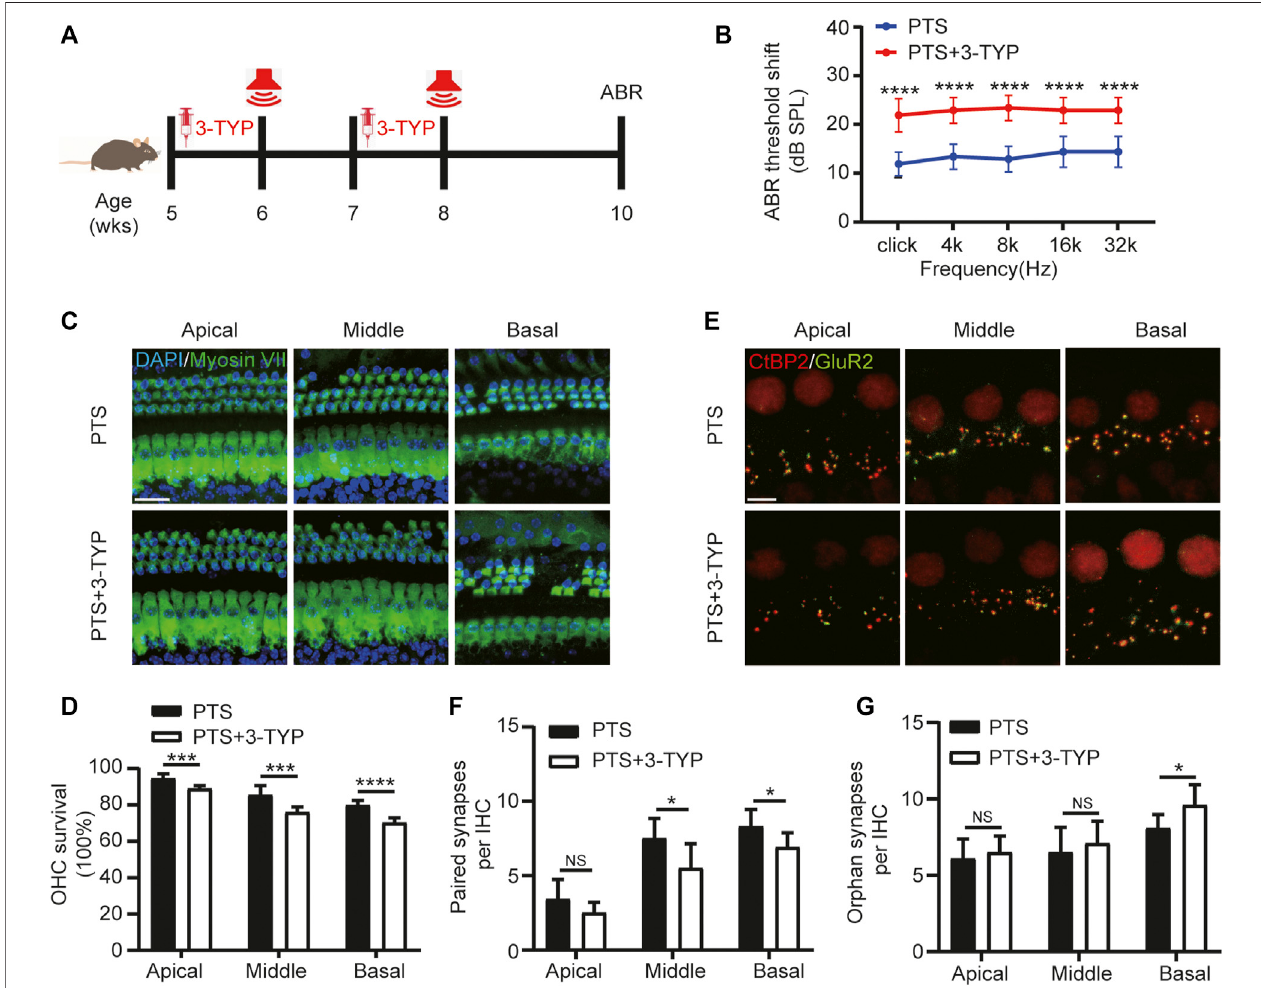
FIGURE4| EffectofSIRT3inhibitorsonhaircellsinthePTSgroup. (A) Scheduleof3-TYPandNEadministrationtoC57BL/6 Jmice. (B) ABR fi ndingsshowingthe effect of 3-TYP on the hearing threshold in mice after NE. (C) Immunohistochemical staining showing 3-TYP-induced changes in the number of hair cells (Myosin VII, green; DAPI, blue) after NE. (D) Quanti fi cation of Myosin VII and DAPI-positive HCs. (E) Immunohistochemical staining showing the effect of 3-TYP on the number of presynaptic (CtBP2, red) and postsynaptic (GluR2, green) structures after NE. (F) Quanti fi cation of CtBP2 and GluR2 overlapping fl uorescent spots. (G) Quanti fi cation of CtBP2 or GluR2 fl uorescent spots alone. ( n (cid:1) 10 per group). PTS, permanent threshold shift; NE, noise exposure; ABR, auditory brainstem response; DAPI,4, 6-diamidino-2-phenylindole;OHC, outer hair cell, IHC, inner hair cell. NS, notsigni fi cant;* p < 0.05; *** p < 0.001; **** p < 0.0001. Scalebars: C, 20 μ m; E, 5 μ m.